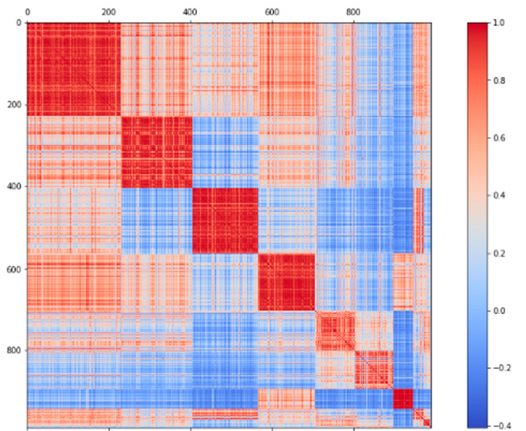
Figure 12. D1, word cloud representation, TF-IDF weighting scheme for LDA modeling.